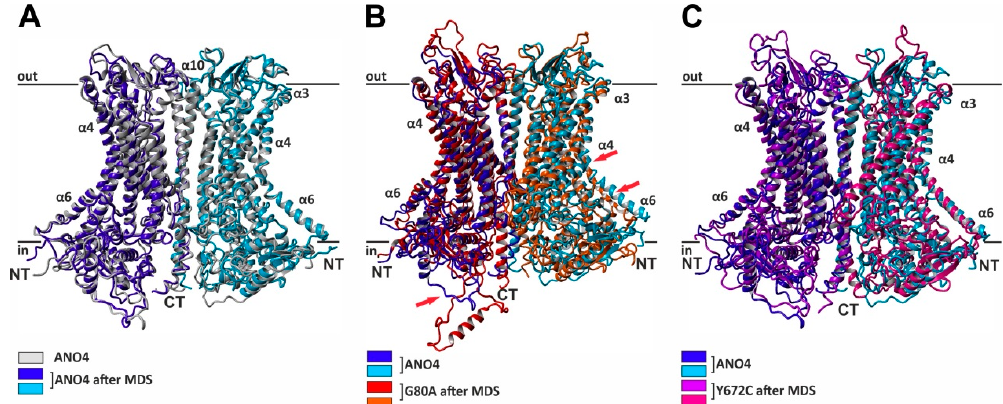
Figure 3. Alignment of the native and mutant ANO4 structures. Ribbon representation of a superposition of ANO4 structures before and after 60 ns of MDS. Subunits are shown in dark and light shades of the corresponding color. Native ANO4 structure before MDS was aligned with ( A ) ANO4 WT, ( B ) G80A, and ( C ) Y672C structures, respectively, after 60 ns of MDS. The mutation at position G80A, which is located in the N-terminal region of the protein destabilized the whole protein, especially the N terminus and the α -helices 4 and 6 (red arrows). The Y672C mutation does not affect the stability of ANO4 protein.